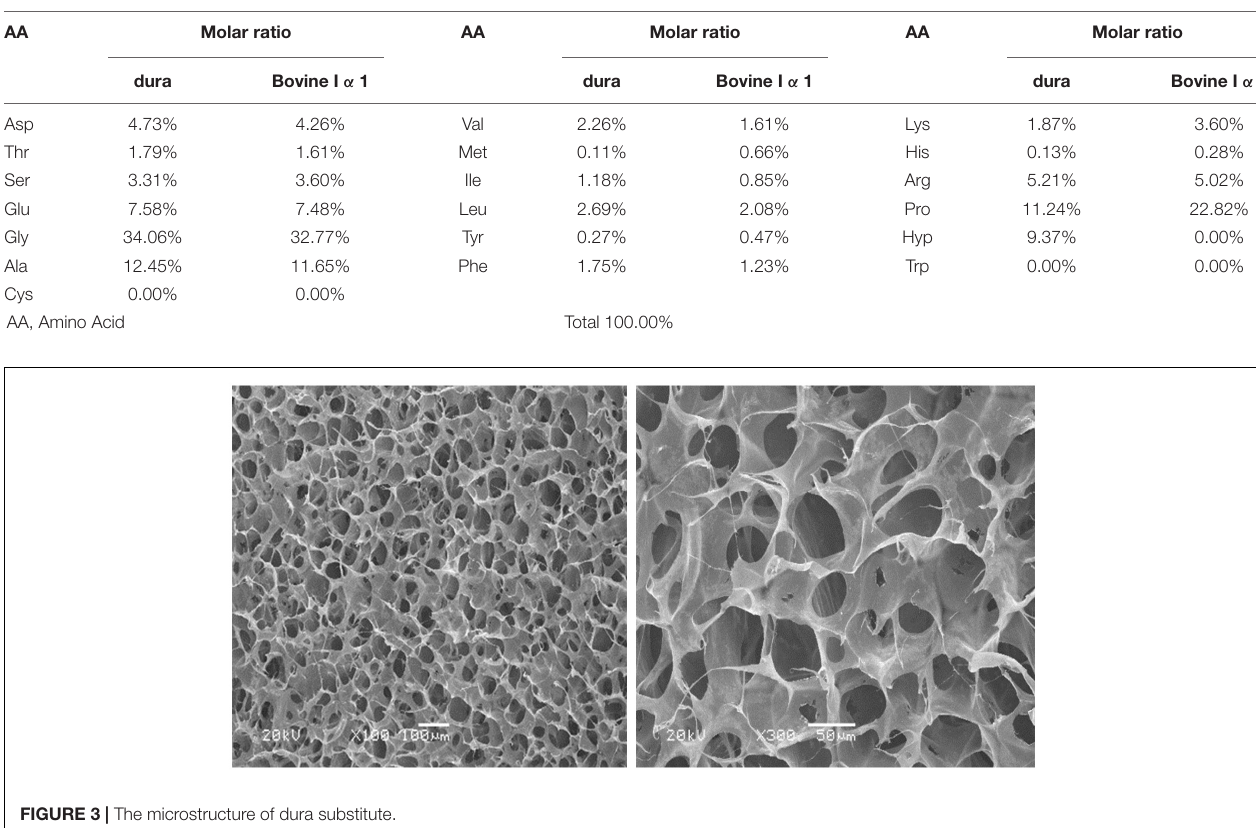
TABLE 2 | The amino acid analysis of dura substitute.